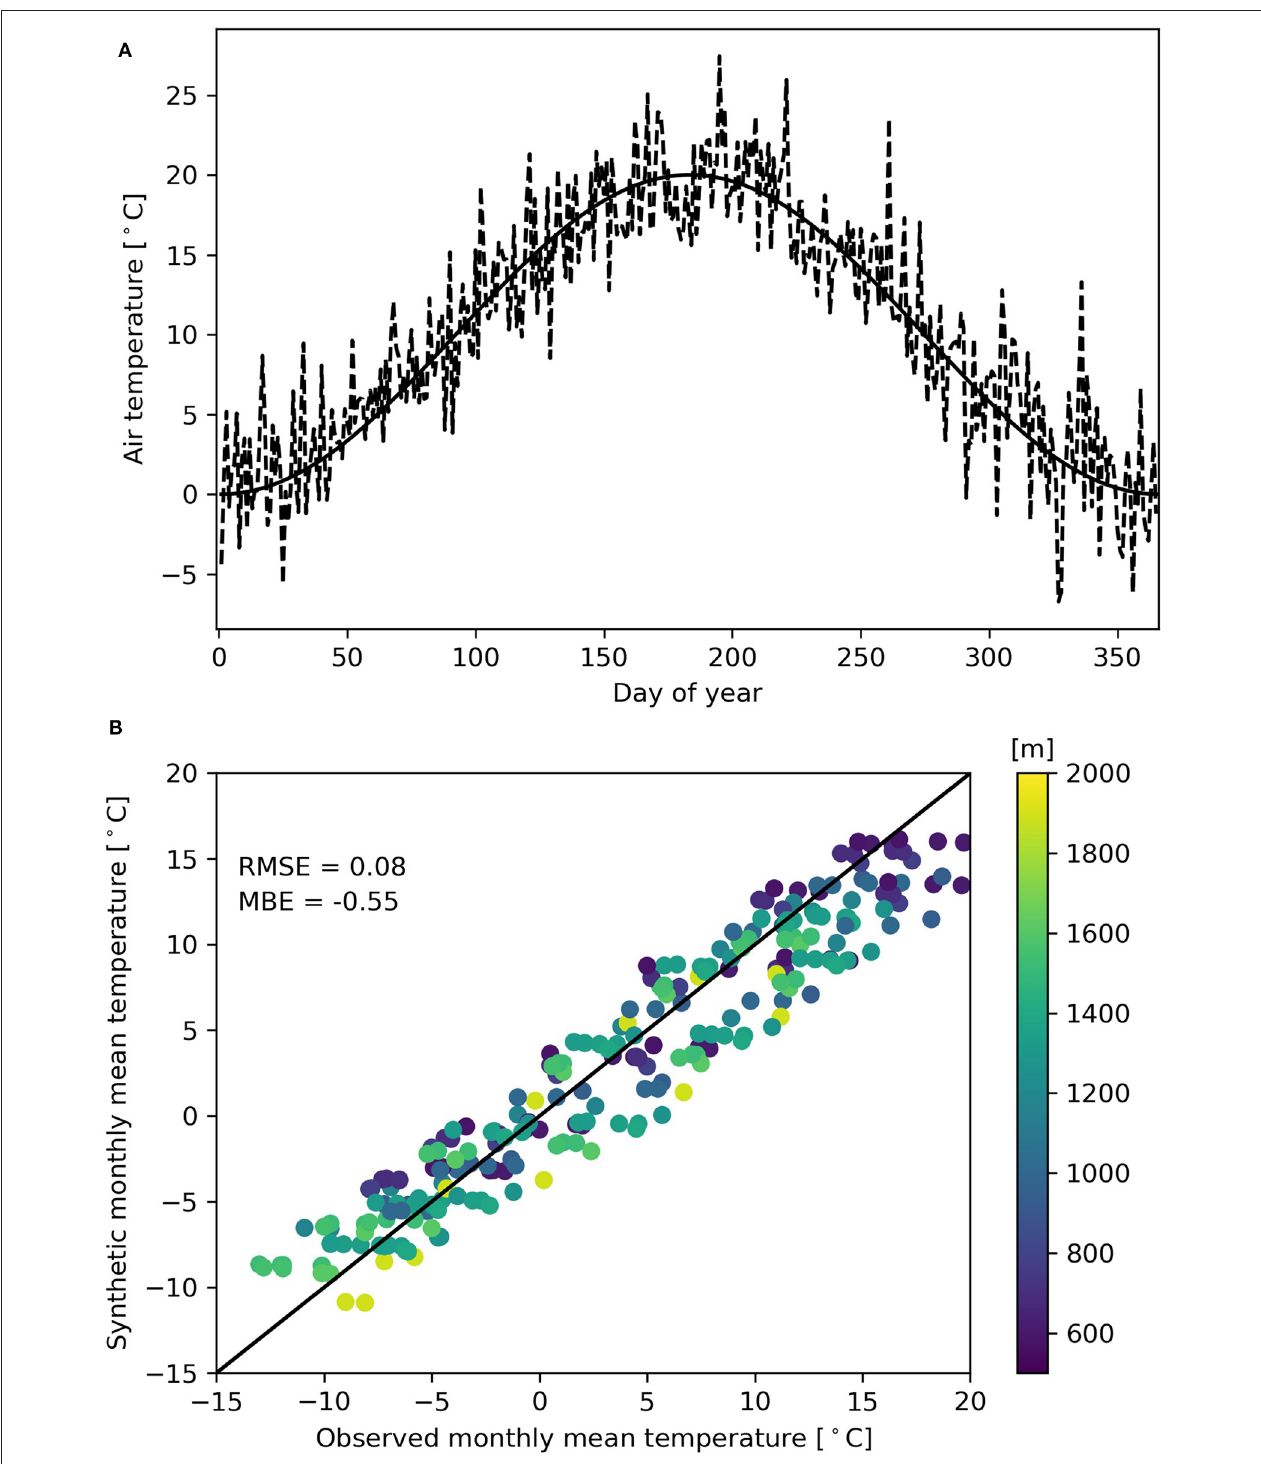
FIGURE 4 | (A) Example synthetic annual temperature series for 2,000m elevation. Mean daily temperatures (solid) are a function of day of year, and random noise (dashed) approximates diurnal variability. (B) Synthetic monthly temperatures vs. 1981–2010 monthly climate normals from 23 stations in the region ( Figure 1 ). Points are color-coded by station